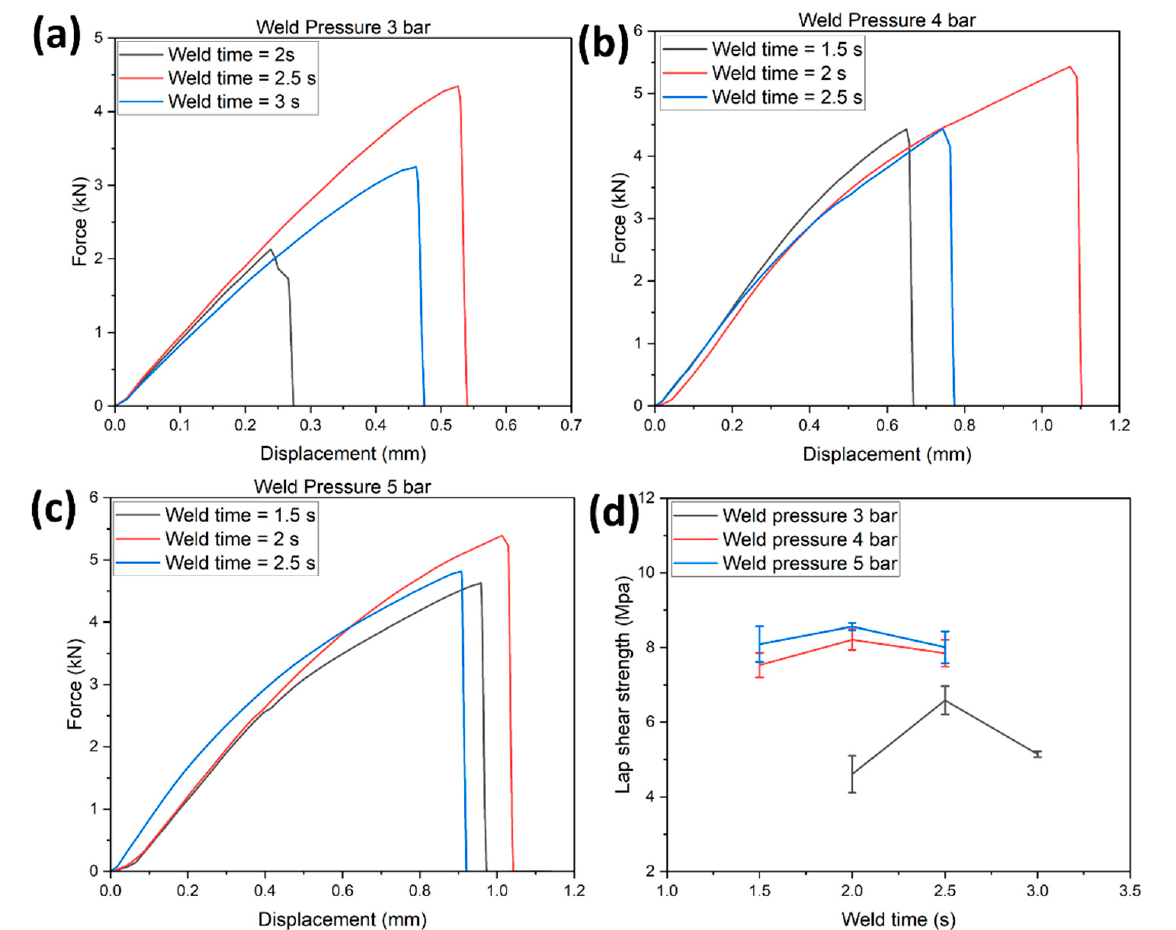
Figure 11. Load-displacement curve for EL-EP(Elium ® -Epoxy)_0.25_0.25: ( a ) Weld pressure = 3 bar, ( b ) Weld pressure = 4 bar, ( c ) Weld pressure = 5 bar. ( d ) Lap shear strength vs. weld time. Figure 13a–c represents the load-displacement curve of tested EL-EP_0.5 samples